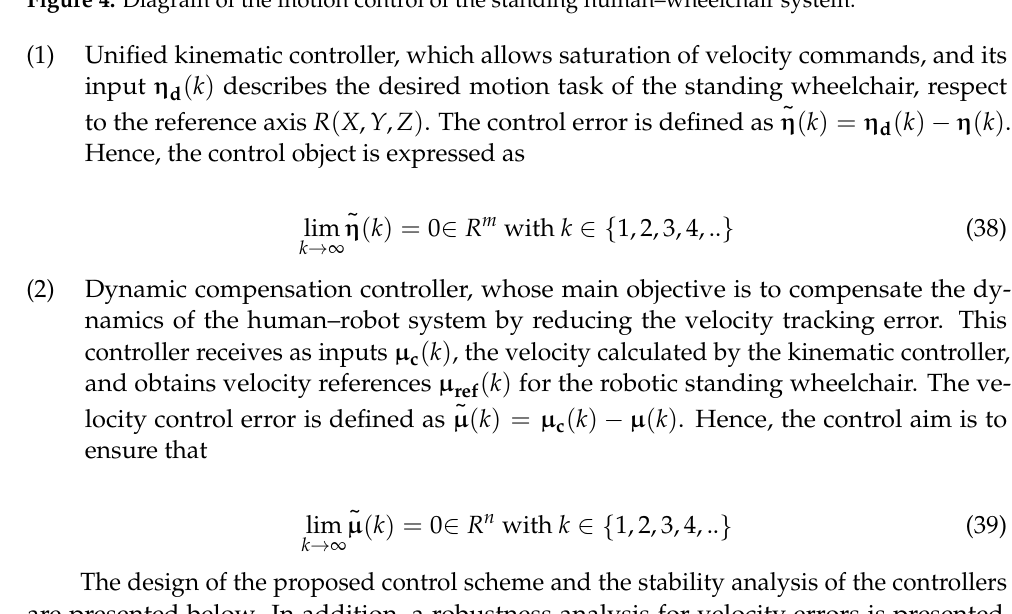
Figure 4. Diagram of the motion control of the standing human–wheelchair